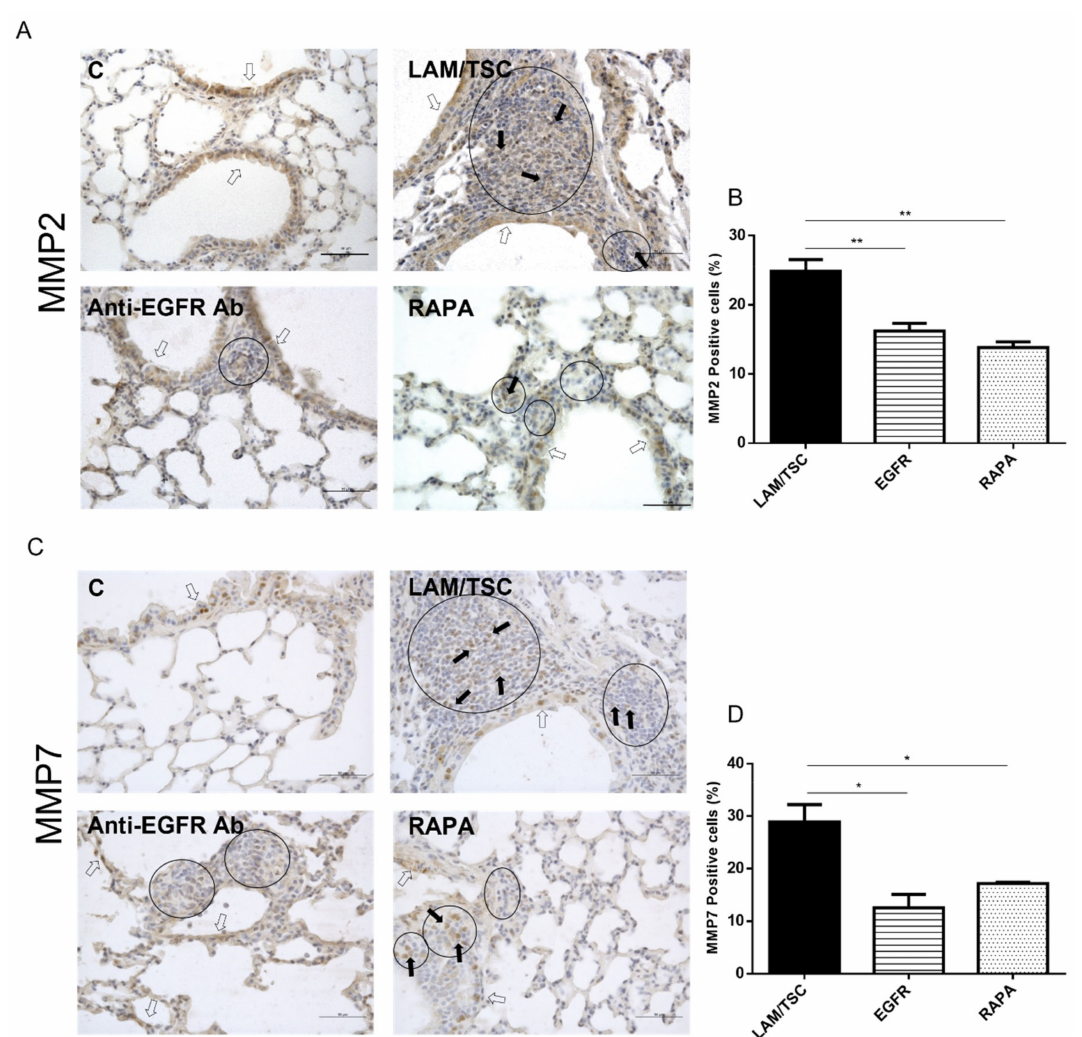
Figure 7. Expression of MMP-2 and MMP-7 in lungs of a LAM mouse model. Representative images of MMP-2 ( A ) and MMP-7 ( C ) expression in lung nodules of a LAM mouse model developed by LAM/TSC cell inhalation. Anti-EGFR antibody and rapamycin cause a reduction of MMP-2 and MMP-7 expression, and a decrease of nodule size. Nuclei were labelled with hematossilin (blue). Circles highlight nodules. Black arrows indicate MMP2 or MMP7 positive cells in nodules; white arrows indicate MMP2 or MMP7 positive cells in lung epithelium. Scale bars: 50 µ m. Quantification of MMP-2 ( B ) or MMP-7 ( D ) positive cells in nodules. The percentage of positive cells on total cells is normalized on the numbers of nodules counted in each section. ANOVA with Tukey test ± SEM ( n = 3 experiments) * p < 0.05, ** p <